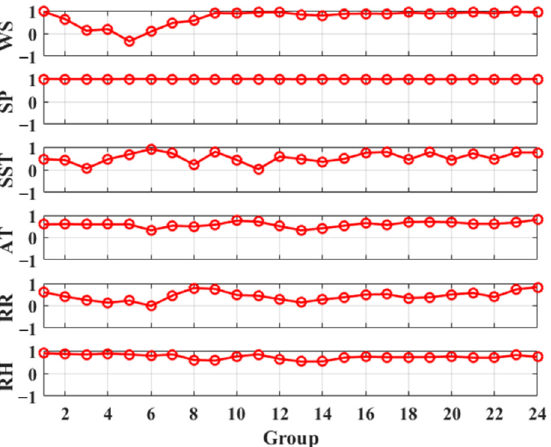
Figure 4. The Pearson correlation coefficients of TAO52087 buoy data and ERA5 reanalysis data in 2020.